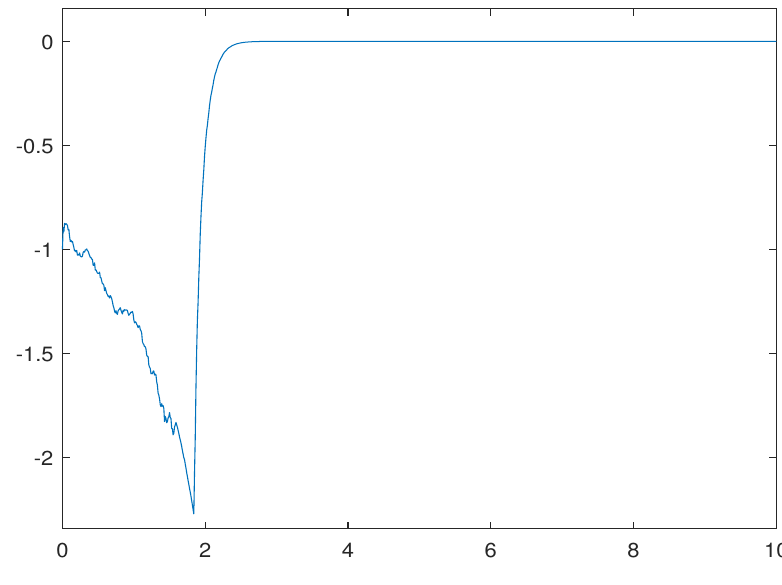
Figure 3. Computer simulation of the solution x ( t ) of Equation